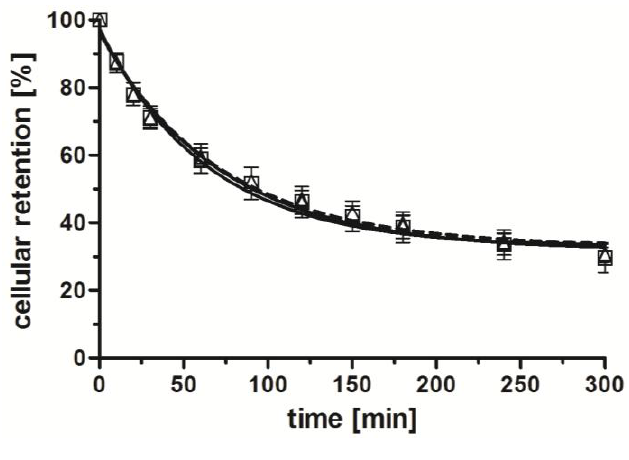
Figure 4. Externalization of radiolabeled compounds [ 99m Tc(CO) PC-3 cells; [ 99m Tc(CO) ( 14 )] (□, continuous line), [ 99m Tc(CO) 3 [ 99m Tc(CO) ( 16 )] (○, continuous line); n = 4–7 (in triplicates, reported by means ± SD; 3 calculated by non-linear regression using GraphPad Prism